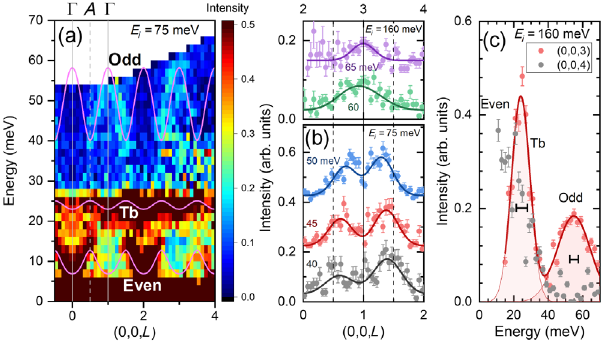
FIG. 5. (a) Slices of the intensity dispersion along ð 0 ; 0 ; L Þ with E ¼ 75 meV show the odd branch between 40 and 60 meV. Pink i lines correspond to the model dispersion relation obtained from fits described below. Gray vertical lines identify Brillouin zone centers (solid) and zone boundary points (dashed), as labeled on the top axis. (b) Constant energy cuts along ð 0 ; 0 ; L Þ at E i ¼ 75 meV (lower panel) and 160 meV (upper panel) summed over Δ H ¼ (cid:4) 0 . 1 , Δ K ¼ (cid:4) 0 . 058 r : l : u : , and Δ E ¼ (cid:4) 2 . 5 meV. Gaus- sian fits reveal the dispersion of the odd branch. (c) Constant- q cuts at (0,0,3) and (0,0,4) summed over Δ H ¼ (cid:4) 0 . 1 , Δ K ¼ (cid:4) 0 . 058 , and Δ L ¼ 0 . 25 r : l : u : showing even, Tb, and odd modes at the Γ point.